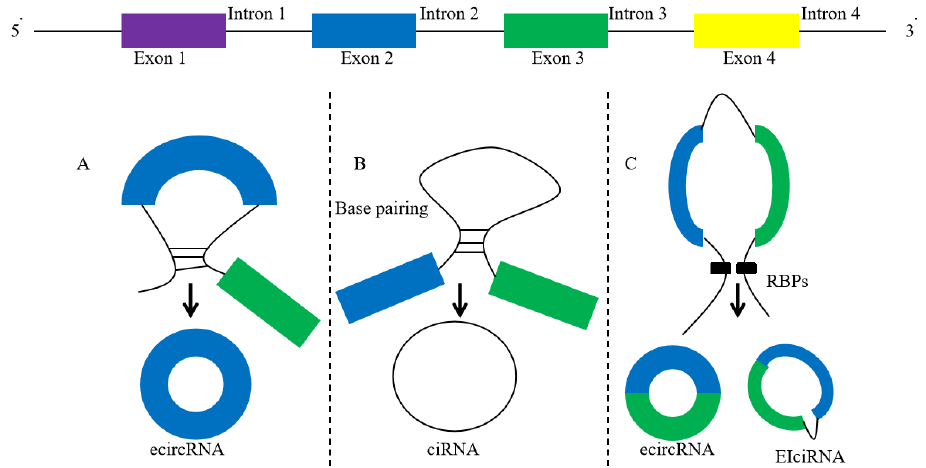
Figure 1. The characteristics of circRNAs and the models of their circularization (intron pairing-driven circularization). ( A ): exonic circRNA (ecircRNA), ( B ): intronic RNA (ciRNA), ( C ): circularization of ecircRNA and EIciRNA through RNA-binding protein (RBP).